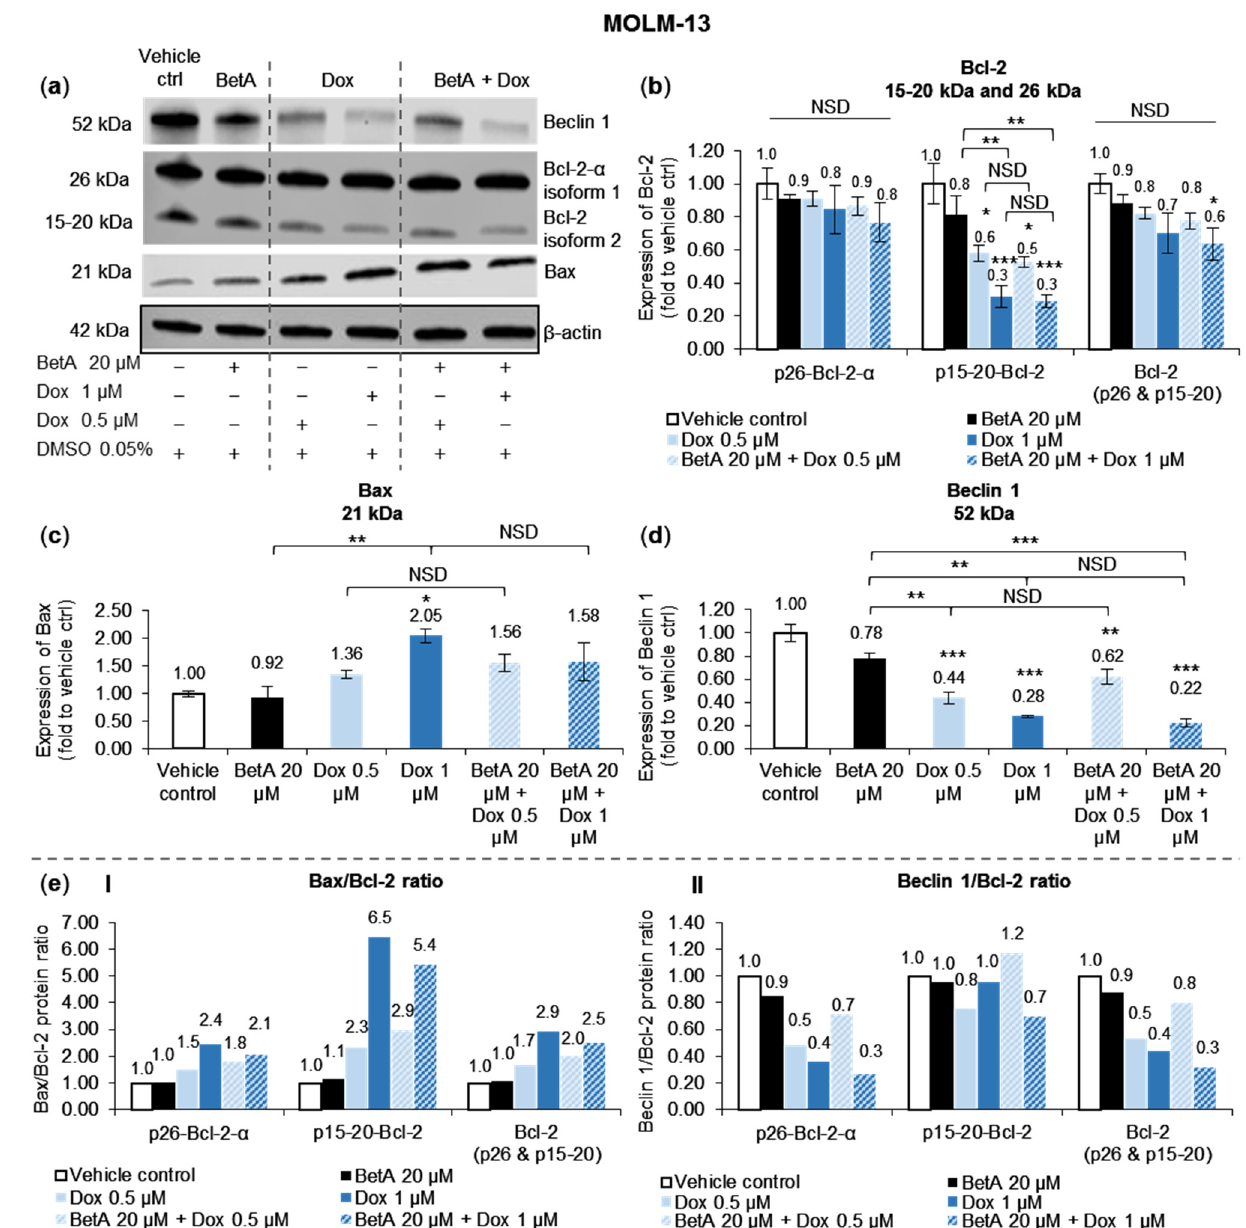
Figure 4. The effects of BetA, Dox and combination on apoptotic Bcl-2 family and autophagy Beclin 1 protein expressions on the MOLM-13 cell line. The protein expressions of BH3-containing proteins, autophagic Beclin 1 (52 kDa), anti-apoptotic Bcl-2 (26 and 15–20 kDa) and pro-apoptotic Bax (21 kDa) were estimated by Western blot ( a ). Experimental samples were run on the same gel and shown protein expressions are on the same blot for each protein antibody. Bcl-2 ( b ), Bax ( c ) and Beclin 1 ( d ), protein levels were determined by normalising quantified protein intensity relative to vehicle control (DMSO 0.05%, represented as 1.00-fold) and ratio between normalised data and β -actin (housekeeping protein). Data were expressed as mean + SE ( n = 3) and analysed by one-way ANOVA; Tukey post-hoc test. Statistical difference was accepted as following: p > 0.05 no significant difference (NSD), * p ≤ 0.05 significant, ** p ≤ 0.01 highly significant, *** p ≤ 0.001 very highly significant. Relative change in the ratio ( e ) of Bax/Bcl-2 ( I ) and Beclin1/Bcl-2 ( II ) were expressed as the fraction of the mean protein levels.